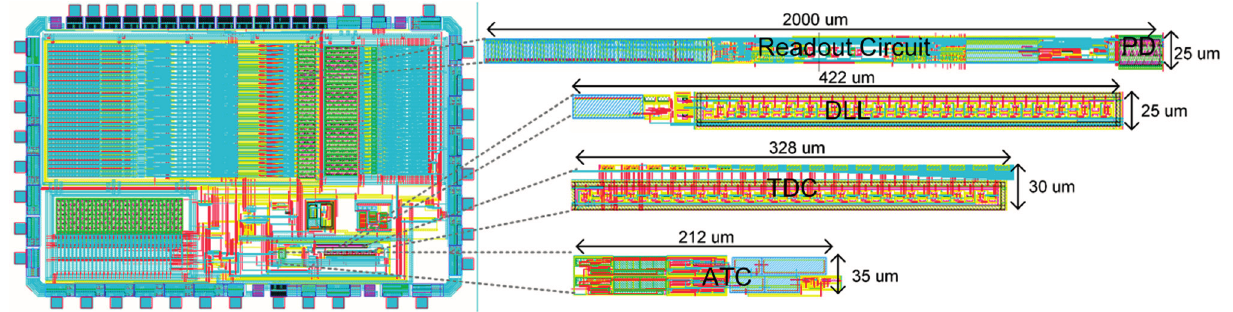
Figure 12. Layout of the linear image sensor.